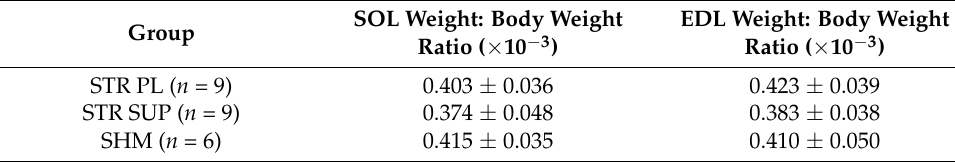
EDL Weight: Body Weight Ratio ( × 10 − 3 )